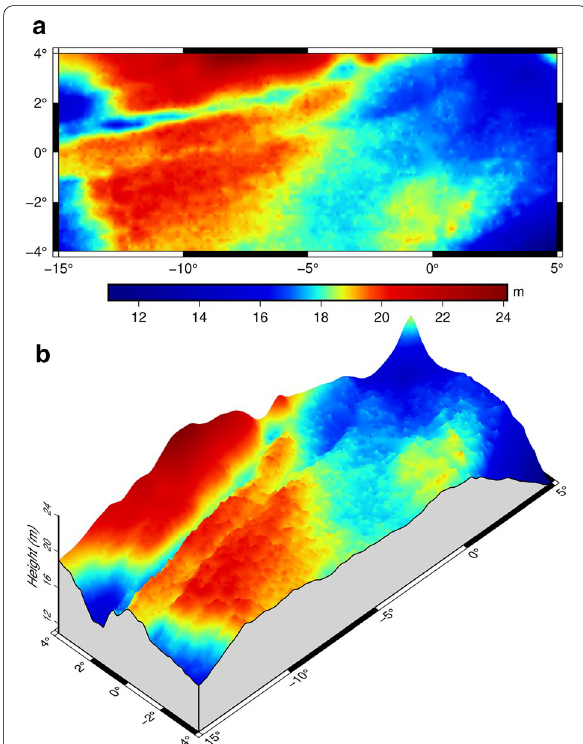
Fig. 4 Self-crossover errors of